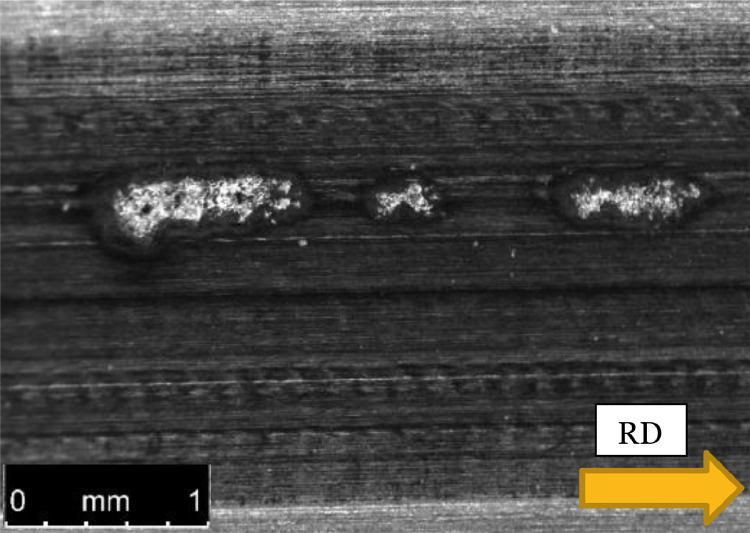
Pits in the counter-disc caused by high asperities, δ = 15 µm, and high contact pressure, pHertz = 2.3 GPa.